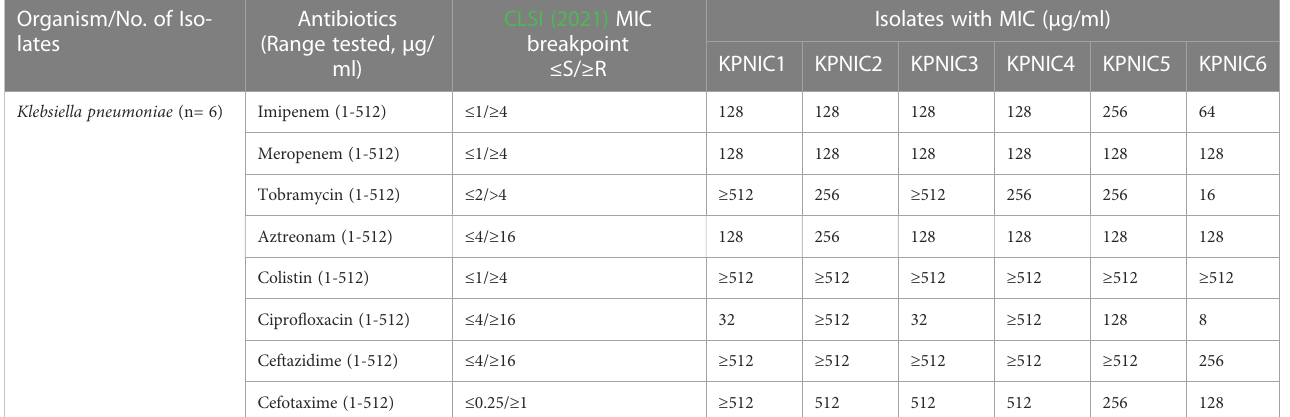
TABLE 2 Antimicrobial susceptibility and minimum inhibitory concentration (MIC) table of K. pneumoniae isolates. Organism/No. of Iso- lates